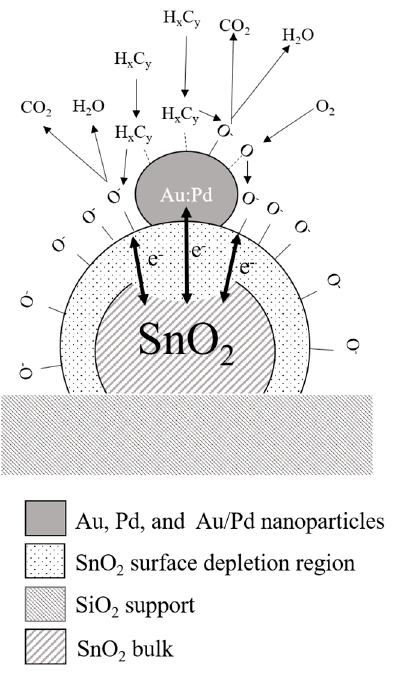
Figure 14. A schematic diagram of the gas sensing mechanism of polycrystalline SnO 2 functionalized with bimetal nanoparticles with a hybrid sensitization type, when spill-over and electric mechanisms complement and amplify each other.